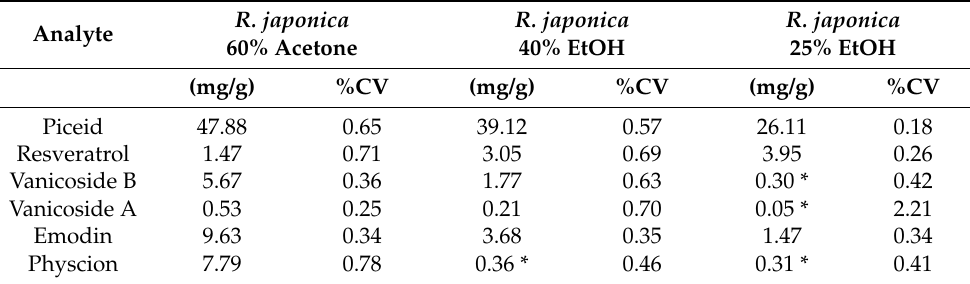
Table 5. Content of analyzed compounds in studied extracts (mg/g of raw extract dry